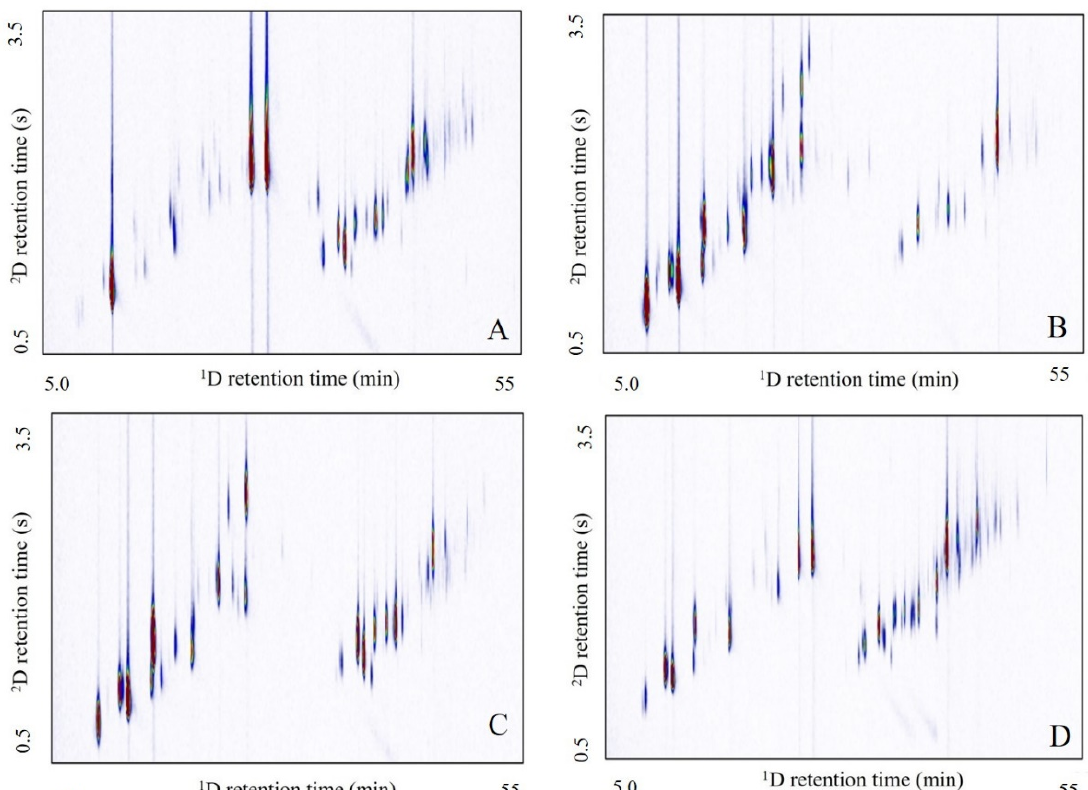
Figure 3. GC × GC-MS total ion chromatograms (TIC) of essential oils of new L. alba genotypes: ( A ) X6M6, ( B ) X6M13, ( C ) X6M15, and ( D ) X10M37.